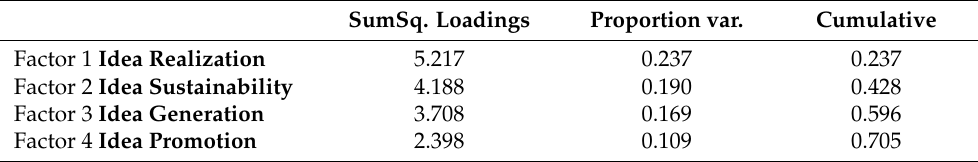
Table 2. Factor eigenvalues and variance explained (First study).